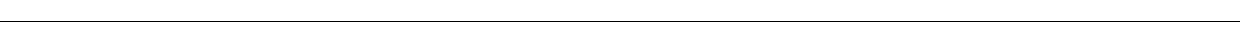
Fig. 2 Transient expression of reprogramming factors induces reversible acinar to ductal metaplasia. a A schematic illustration of the genetic construct of Pdx1 ires-Cre, Rosa LSL-rtTA3, Col1a1::tetO-OSKM-ires-mCherry (C-OSKM) mice. b Experimental protocol for Dox treatment in C-OSKM mice. c Immuno fl uorescent images for Amylase and CK19 in the pancreas of C-OSKM mice. CK19 expression is observed in the acinar area of C-OSKM mice after Dox treatment for 3 days. Scale bars, 50 μ m. d Immuno fl uorescent images for Oct3/4 and CK19 in the pancreas of C-OSKM mice. Transgenic Oct3/4 expression is coincident with the CK19-positive lesions. Scale bars, 50 μ m. e Reversible ductal metaplasia by the transient expression of reprogramming factors. CK19 staining is hardly detected in the acinar area after Dox withdrawal for 1 week. Scale bars, 50 μ m. f Quanti fi cation of the CK19-positive area in the pancreas of C-OSKM mice. A box-and-whisker plot of the CK19-positive area. Solid lines in each box indicate the median. Bottom and top of the box are lower and upper quartiles, respectively. Whiskers extend to ±1.5 interquartile range (IQR). Numbers in parentheses indicate the number of mice examined. *** p < 0.001, Mann – Whiteney U -test. n.s. not signi fi cant. g A schematic illustration of the genetic constructs of Rosa M2-rtTA , Col1a1::tetO-SNEL-ires- mCherry (KH2- SNEL ) mice. Polycistronic cassette was used for SNEL induction. h Experimental protocol for Dox treatment in KH2- SNEL chimeric mice. i CK19 expression in Dox-treated KH2- SNEL chimeric mice. ADM lesions are observed after SNEL expression for 2 weeks. Scale bar, 50 μ m. j Immuno fl uorescent images for Amylase and CK19 staining in KH2- SNEL chimeric mice. CK19 expression is observed in the amylase-positive acinar area after SNEL expression. Scale bars, 50 μ